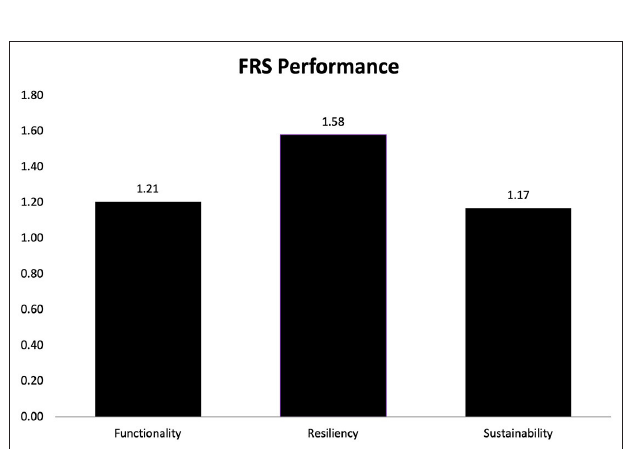
FIGURE 3 | Final FRS results for South Windsor Stormwater